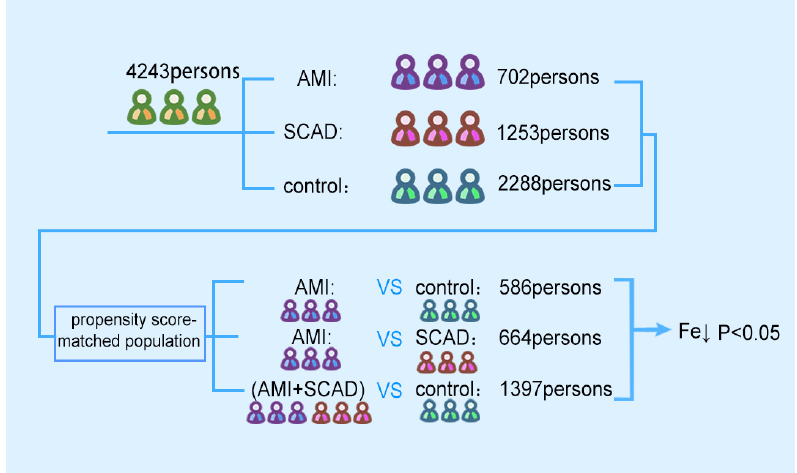
Figure 1. Flow chart of the study. The flow chart consists of the data before and after propensity matching. Iron ions were at low levels before and after propensity matching. AMI: acute myocardial infarction; SCAD: stable coronary artery disease.